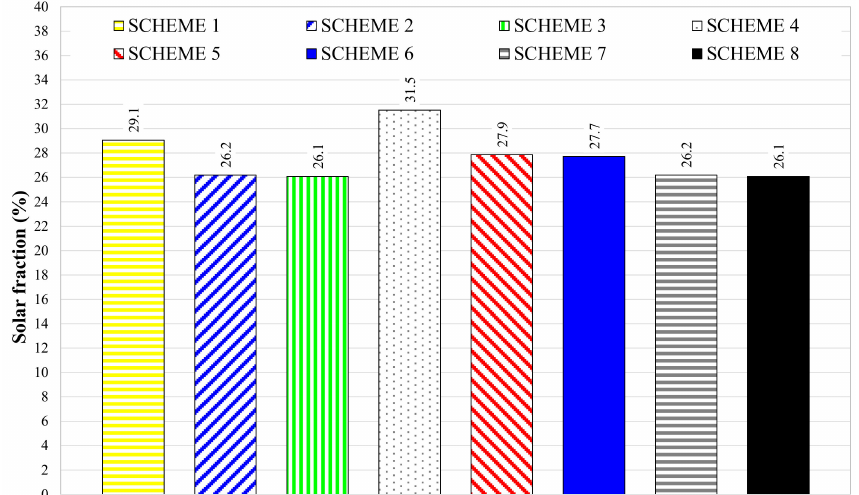
Figure 13. SF 5th-year upon varying the CSHPSS scheme.